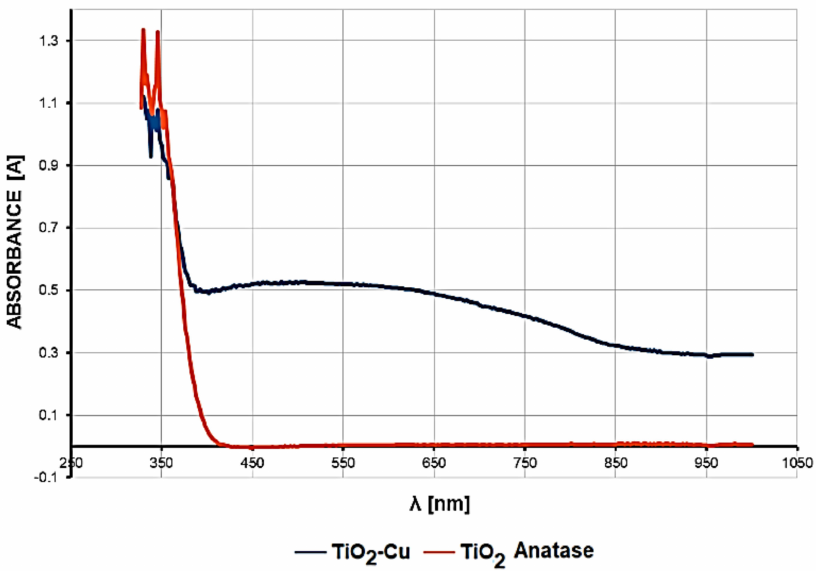
Figure 4. UV-Vis optical absorption spectra of 2% copper-doped TiO 2 pigment compared to undoped TiO 2 .